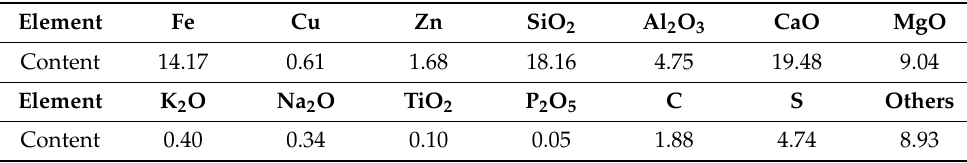
Table 1. Chemical composition of the polymetallic ore